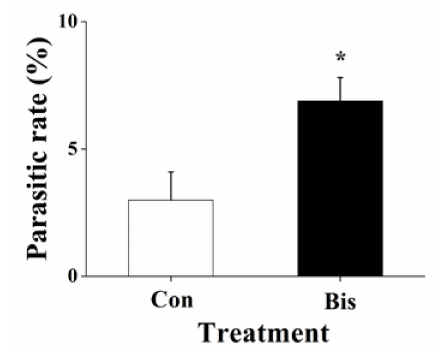
Figure 5. Mean parasitism rates (+ SE, n = 15) of WBPH eggs by A. nilaparvatae on the plants that